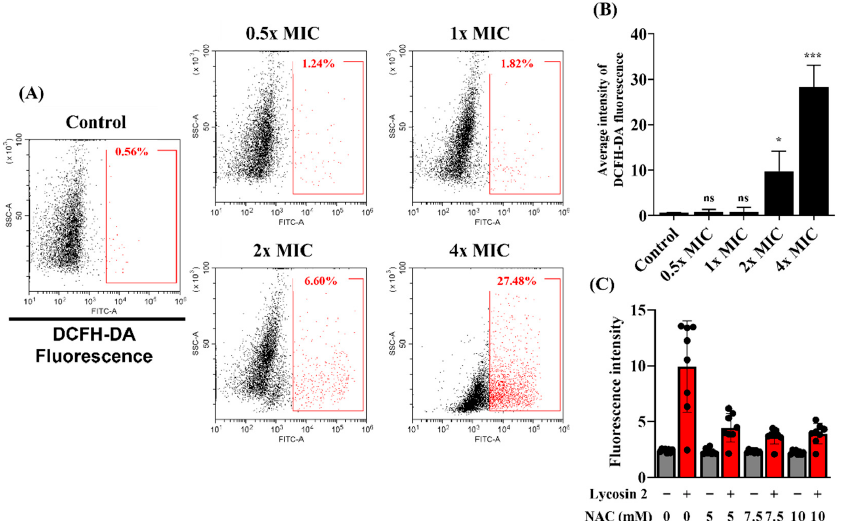
Figure 4. Analysis of reactive oxygen species (ROS) induced by Lycosin-II in Candida albicans . ( A ) ROS production in C. albicans added to Lycosin-II was measured using DCFH-DA detection and flow cytometry. ( B ) The statistical analyses are displayed as averages ( n = 3). ( C ) The effect of N-acetyl cysteine (NAC) at different concentrations on membrane integrity using SYTOX green. Black dot indicated fluorescence intensity of SYTOX green. The graph is expressed as the mean ± standard deviation. Significance: *, p < 0.05; ***, p < 0.001; ns, not significant compared to the control. Abbreviations: DCFH-DA, 2, 7-dichloroflurorescin diacetate ; MIC, minimum inhibitory concentration .